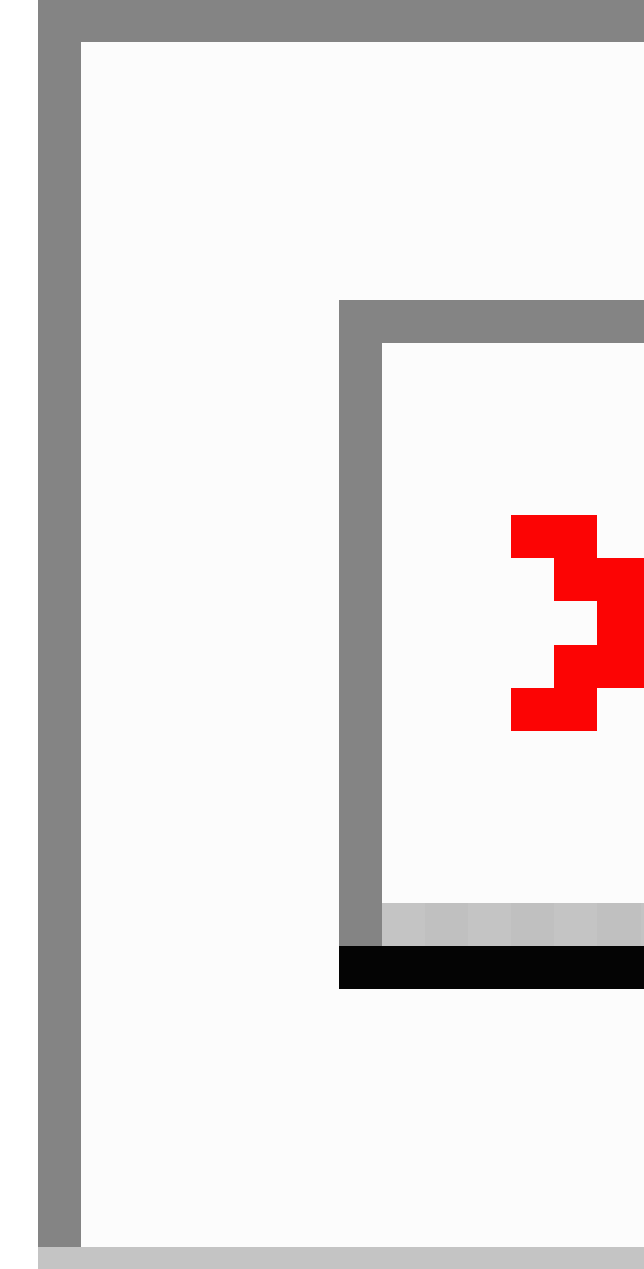
Figure 3. Hypertension management ontology of the